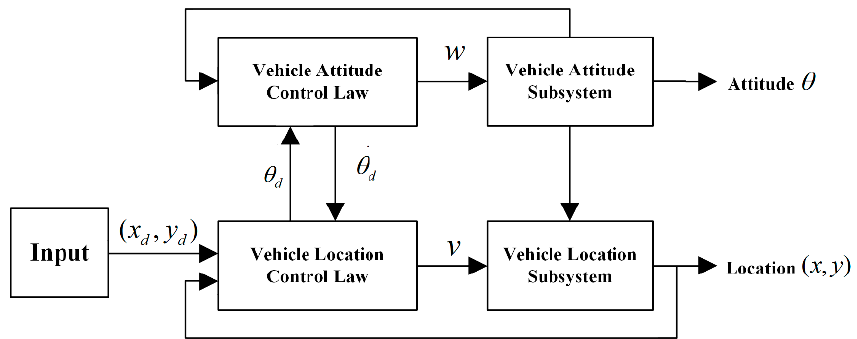
Figure 9. Closed-Loop System of Controller.